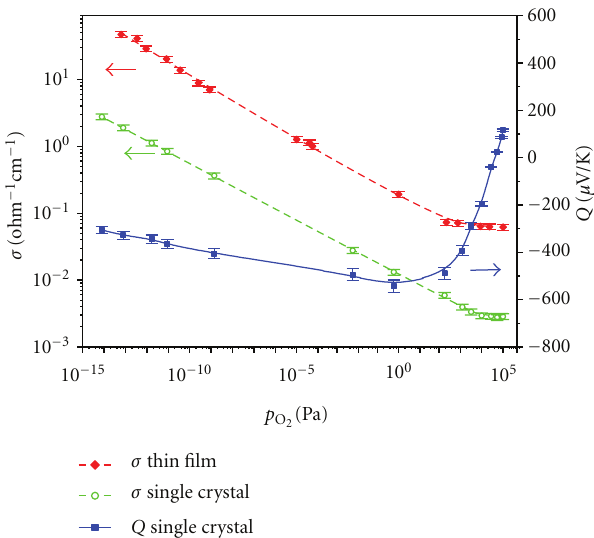
Figure 1: Electrical conductivity σ measured at 1250 K as a function for a thin film of TiO 2 − y . The of the oxygen partial pressure p O 2 results of σ and Seebeck coe ffi cient Q concern rutile single